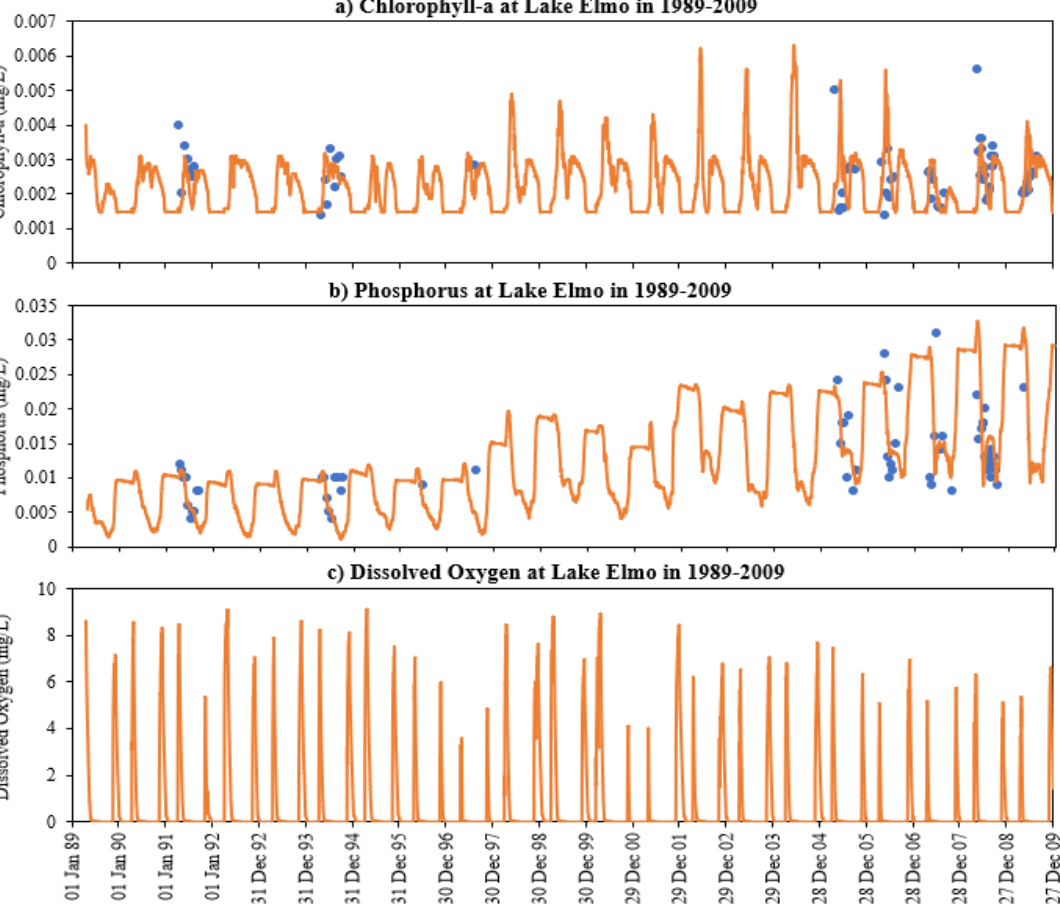
Figure 17. Simulated ( line ) and observed ( dots ) surface (1 m) ( a ) chlorophyll-a, ( b ) phosphorus, and ( c ) dissolved oxygen for long-term simulation of Lake Elmo from 1989 to 2009.